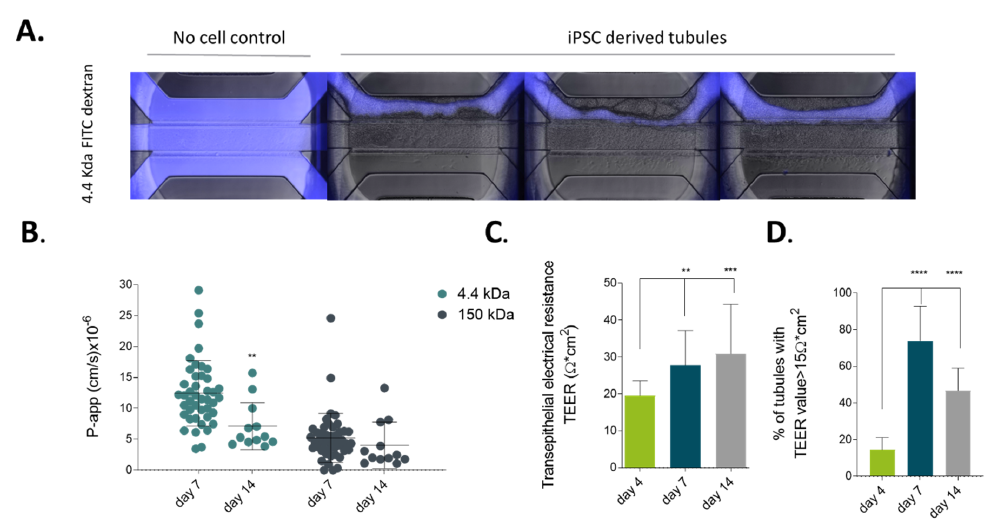
Figure 3. Barrier function of iPSC-derived intestinal-like tubules. ( A ) Merge of fluorescent and phase contrast images of four microfluidic chips perfused in the top channel with fluorescent molecules (in blue) using 4.4 kDa TRITC-Dextran for 15 min on day 25 of culture. The ‘no cell control’ shows the passage of the fluorescent dye into the adjacent gel and secondary perfusion channel, whereas in the chips with iPSC tubules the fluorescent dye is retained by the tubule. ( B ) P-app value calculated based on a fluorescent permeability assay using both 4.4 kDa TRITC-dextran and 150 kDa FITC-dextran at day 7 and day 14. Data are represented as mean ± SD. Significance was detected by two-way Anova, n ≥ 12. ( C ) Transepithelial electrical resistance (TEER) measurements of iPSC-derived intestine-like tubules between day 4 and day 14 of culture (N = 3, n ≥ 110). ( D ) Percentage of iPSC-derived intestine-like tubules between day 4 and day 14 of culture developing TEER values above 15 Ω cm 2 . Significance was detected by ordinary one-way Anova with Dunett’s multiple comparison test. Data are represented as mean ± SD. ( n = 3, n ≥ 110), ns p > 0.05, * p ≤ 0.05, ** p ≤ 0.01, *** p ≤ 0.001, **** p ≤ 0.0001.